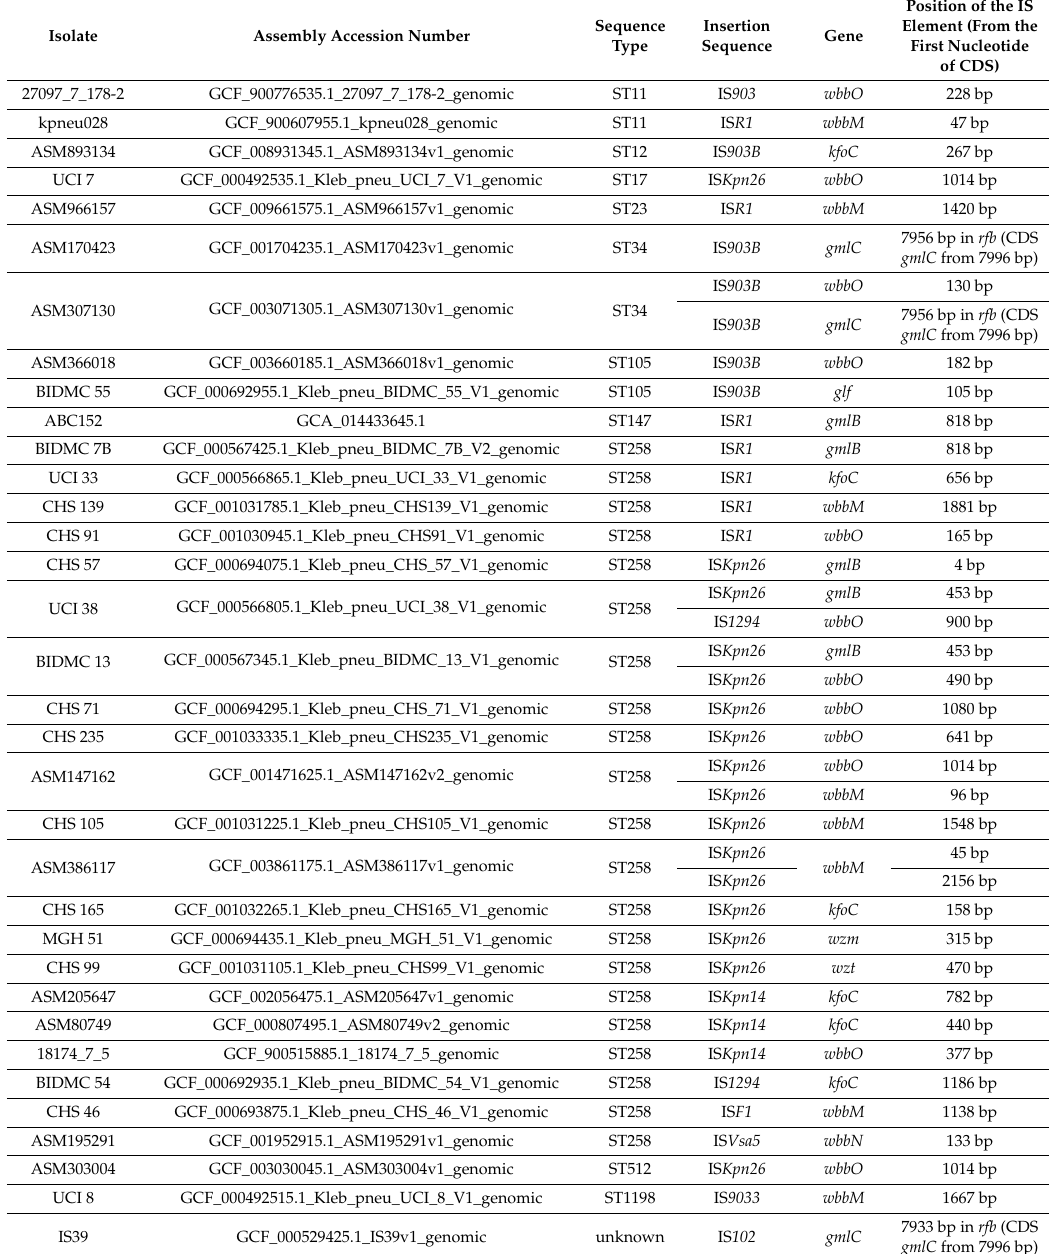
Table 2. Sequence type and location of IS elements in the rfb clusters of K. pneumoniae isolates selected on the basis of Kaptive-based O2v2 predictions a